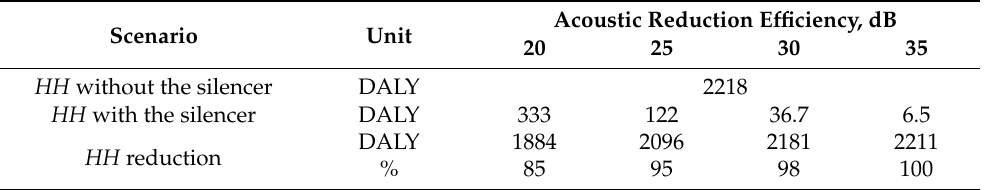
Table 4. Human health indicator for different acoustic reduction efficiencies of the silencer.